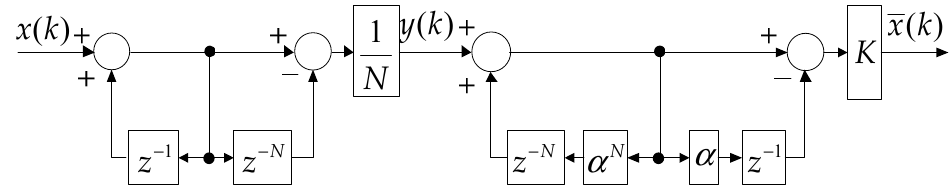
Figure 7. Digital implementation schematic diagram of FAMCF-PLL.